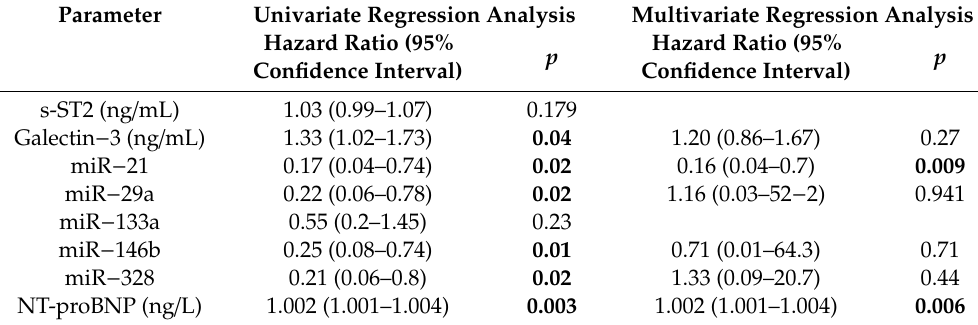
Table 4. Biomarker predicting AF in complete cohort (